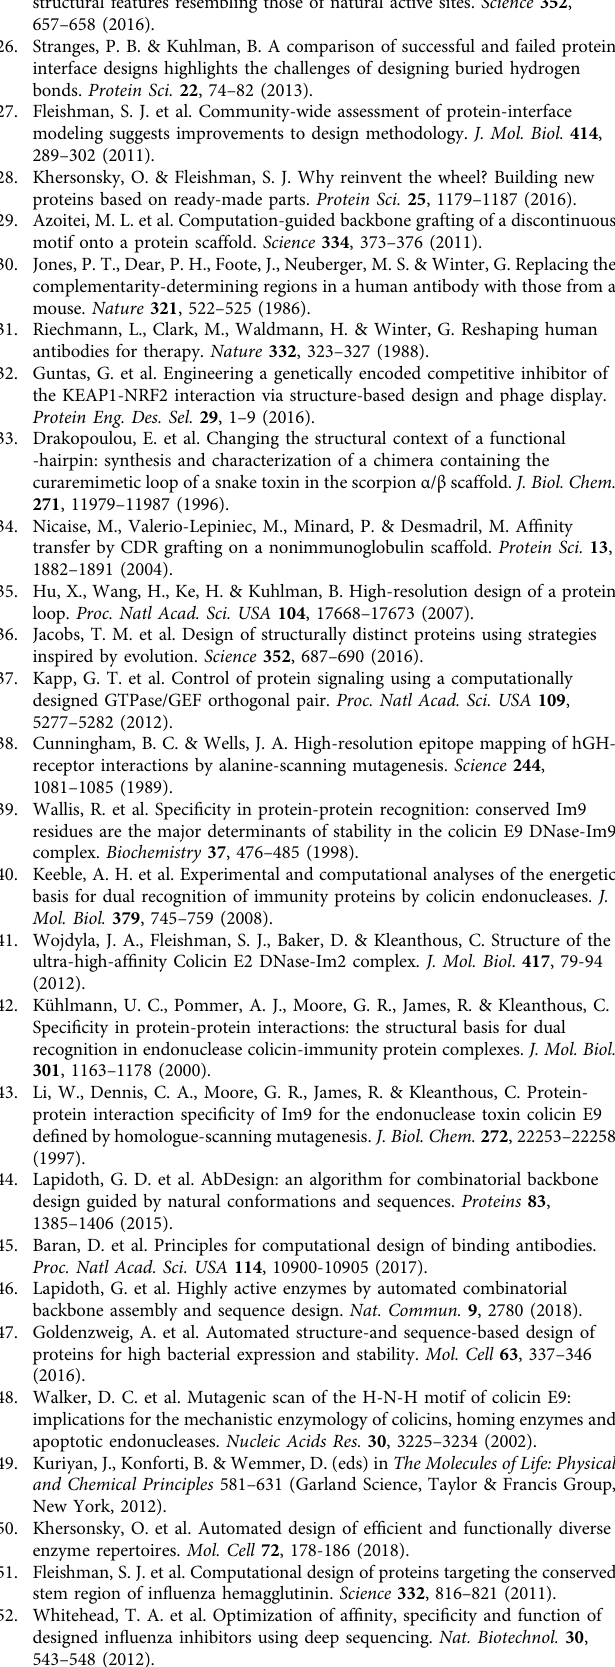
Data availability The amino acid sequences and the computed Rosetta scores of the 59 designs that were tested experimentally and the wild type are available in Supplementary Data 1. The coordinates of the designs colE des3 /Im des3 and colE des7 /Im des7 are available from the RCSB Protein Data Bank with accession codes 6ERE and 6ER6, respectively. Plasmids encoding the 18 successful designs and designed pair 3.5 were deposited in the AddGene repository (https://www.addgene.org/